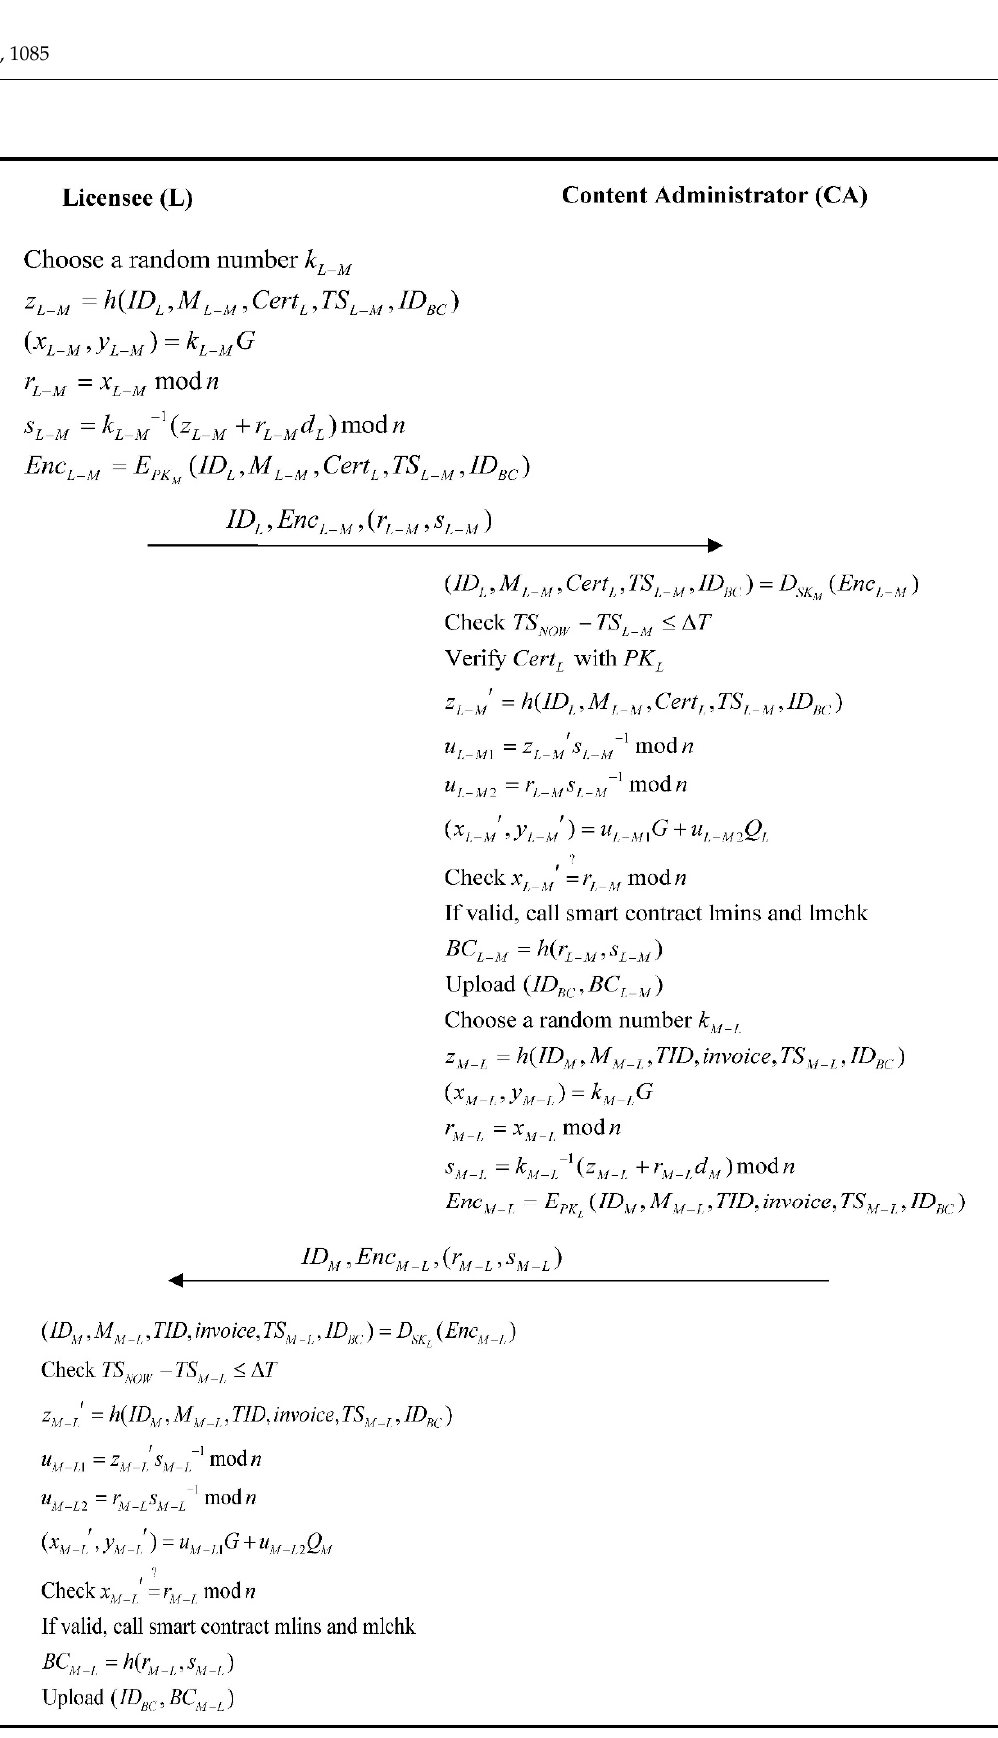
Figure 6. Authentication and issuing invoice phase (direct authorization). If the verification is passed, CA will get the relevant content request information and trigger the smart contracts lmins and lmchk. The content is as follows (Scheme 3):